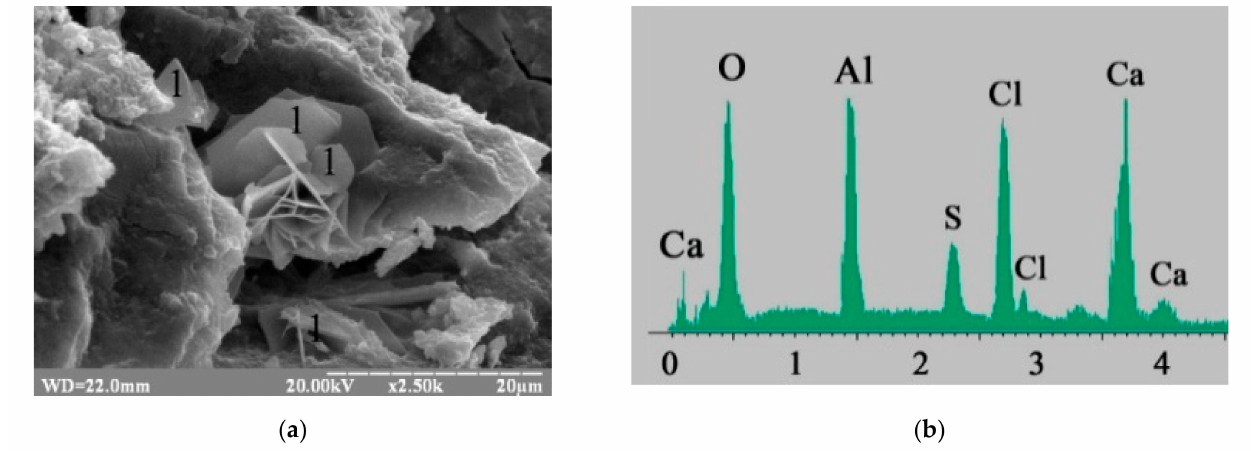
Figure 9. Microstructure of the 180-day hydrated blast furnace cement mixed with sea water and containing Na 2 SiO 3 · 5H 2 O in combination with calcium aluminate cement: ( a ) SEM image; ( b ) Microprobe analysis in point 1.